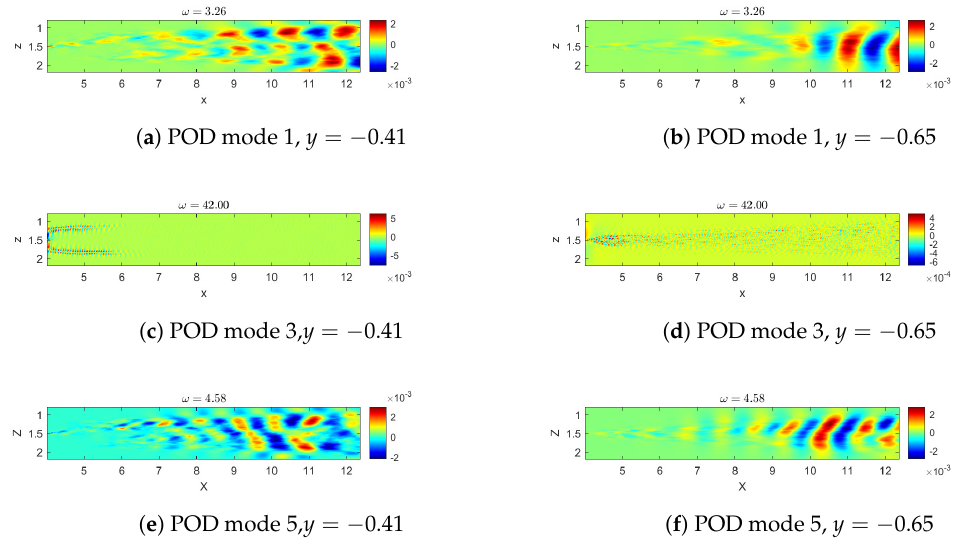
Figure 12. Streamwise velocity contours of the most energetic POD modes on two y -constant